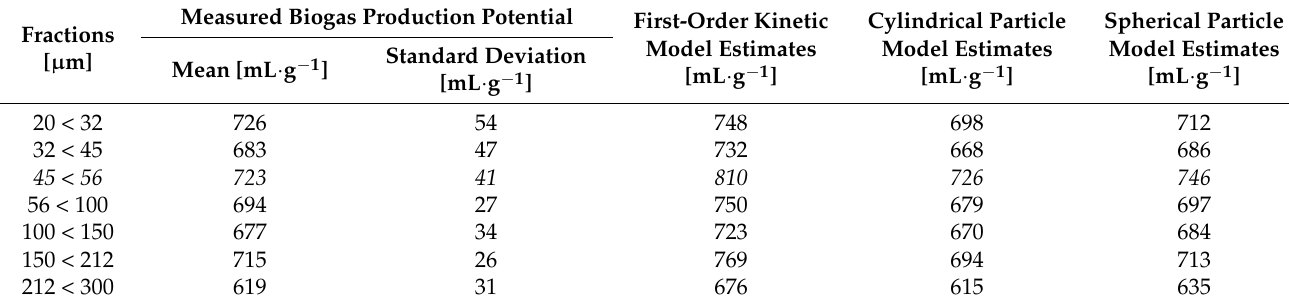
Table 3. Comparison of measured and estimated biogas production